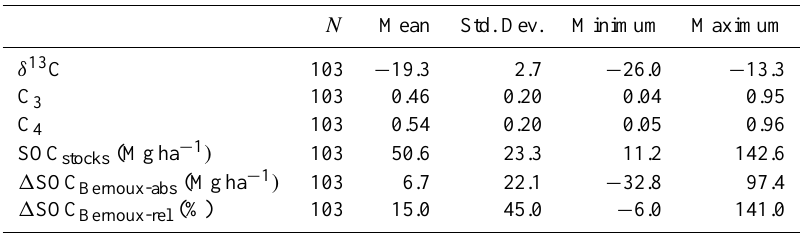
Table 5. Mean, standard deviation (Std. Dev.), minimum, and maximum for δ 13 C, C 3 proportion, C 4 proportion, and carbon stocks (SOC stocks ) at 0–30cm soil depth layer for pasture soils included in the regional survey. 1 SOC Bernoux-abs is the difference between the carbon soil stock of native vegetation obtained by Bernoux et al. (2002) and pasture soils. 1 SOC Bernoux-rel is the same difference expressed as